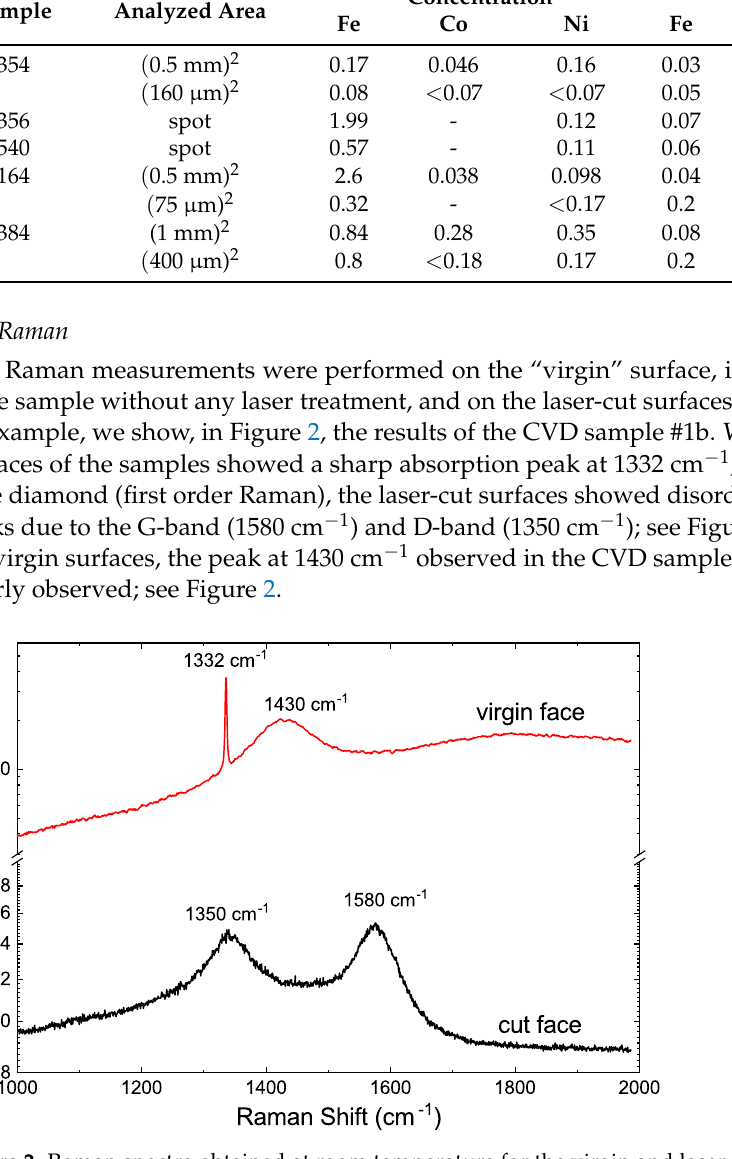
Figure 2. Raman spectra obtained at room temperature for the virgin and laser-cut faces of the CVD sample